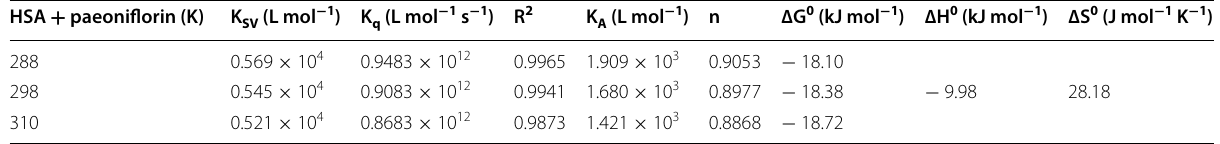
Table 1 Quenching constants (K and K ), stability constants (K ), correlation coefficients (R) and binding site num- SV q a bers (n) and thermodynamic parameters calculated according to Stern–Volmer plots and double logarithm plots of HSA paeoniflorin system at three temperatures +